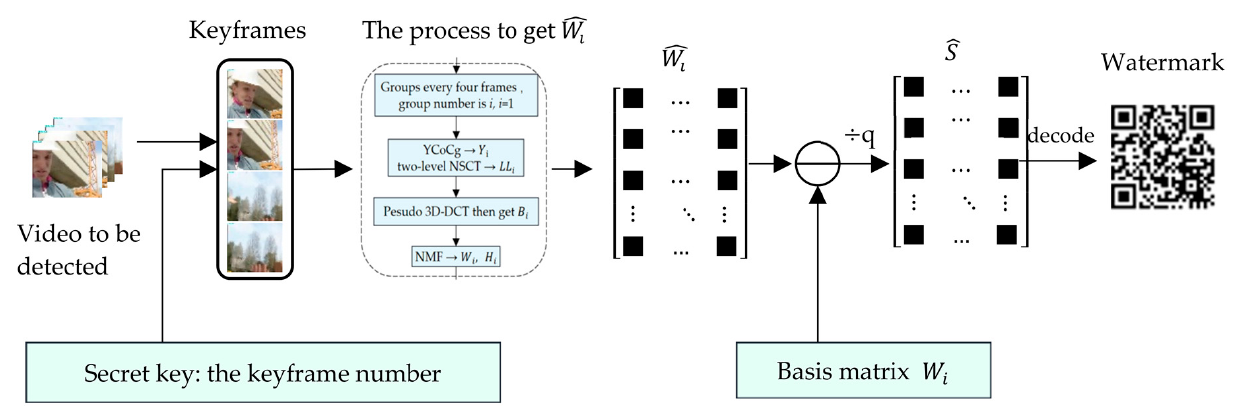
Figure 9. An example of video watermark extraction.